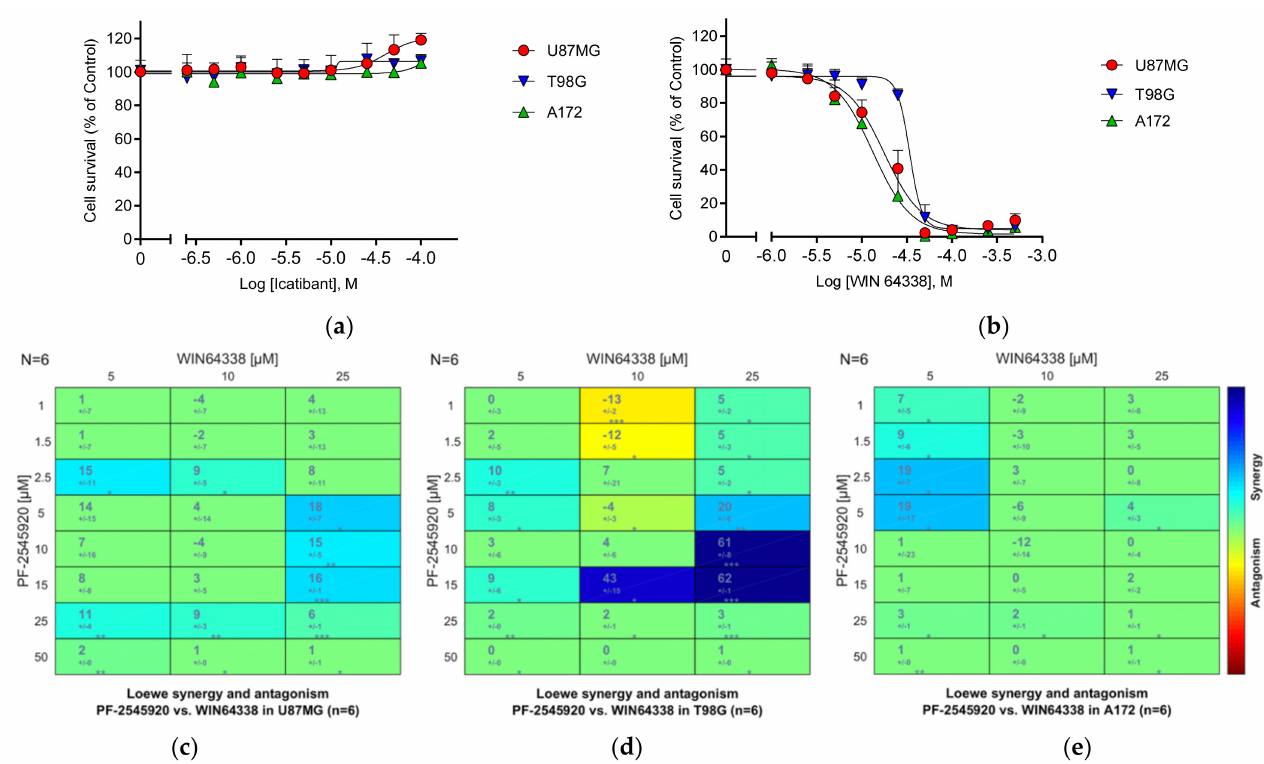
Figure 11. Anti-proliferative effects of bradykinin B2 antagonists on U87MG, A172 and T98G cells. ( a ) Icatibant; ( b ) WIN 64338. Data are presented as the mean ± standard error of the mean (SEM) ( n = 6). Panels ( c – e ) show Loewe synergy plots for the combination of Mardepodect (PF-2545920) and WIN64338 in U87MG, T98G and A172 glioblastoma cells, respectively. T98G cells showed pronounced synergy, with synergy scores rising to 62. Note: Asterisks indicate the significance of synergy scores obtained following a one-sample t -test (* p < 0.05; ** p < 0.001; *** p <